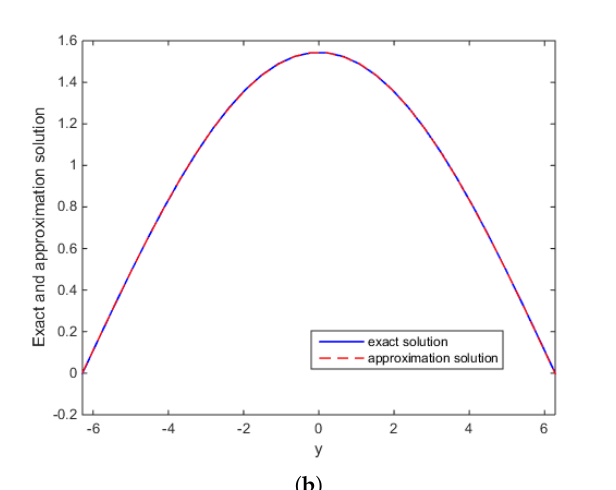
Figure 2. Example 2: The comparison of numerical effects between exact solution and the approximate solution: ( a ) For the case k = 0.8, δ = 1 × 10 − 3 ; ( b ) For the case k = 5, δ = 1 × 10 − 3